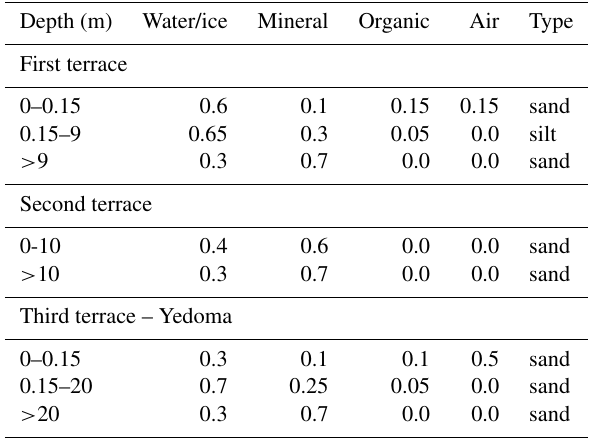
Table 1. Subsurface stratigraphies for the three LRD terraces with volumetric fractions of the soil constituents and sediment type as- signed to each